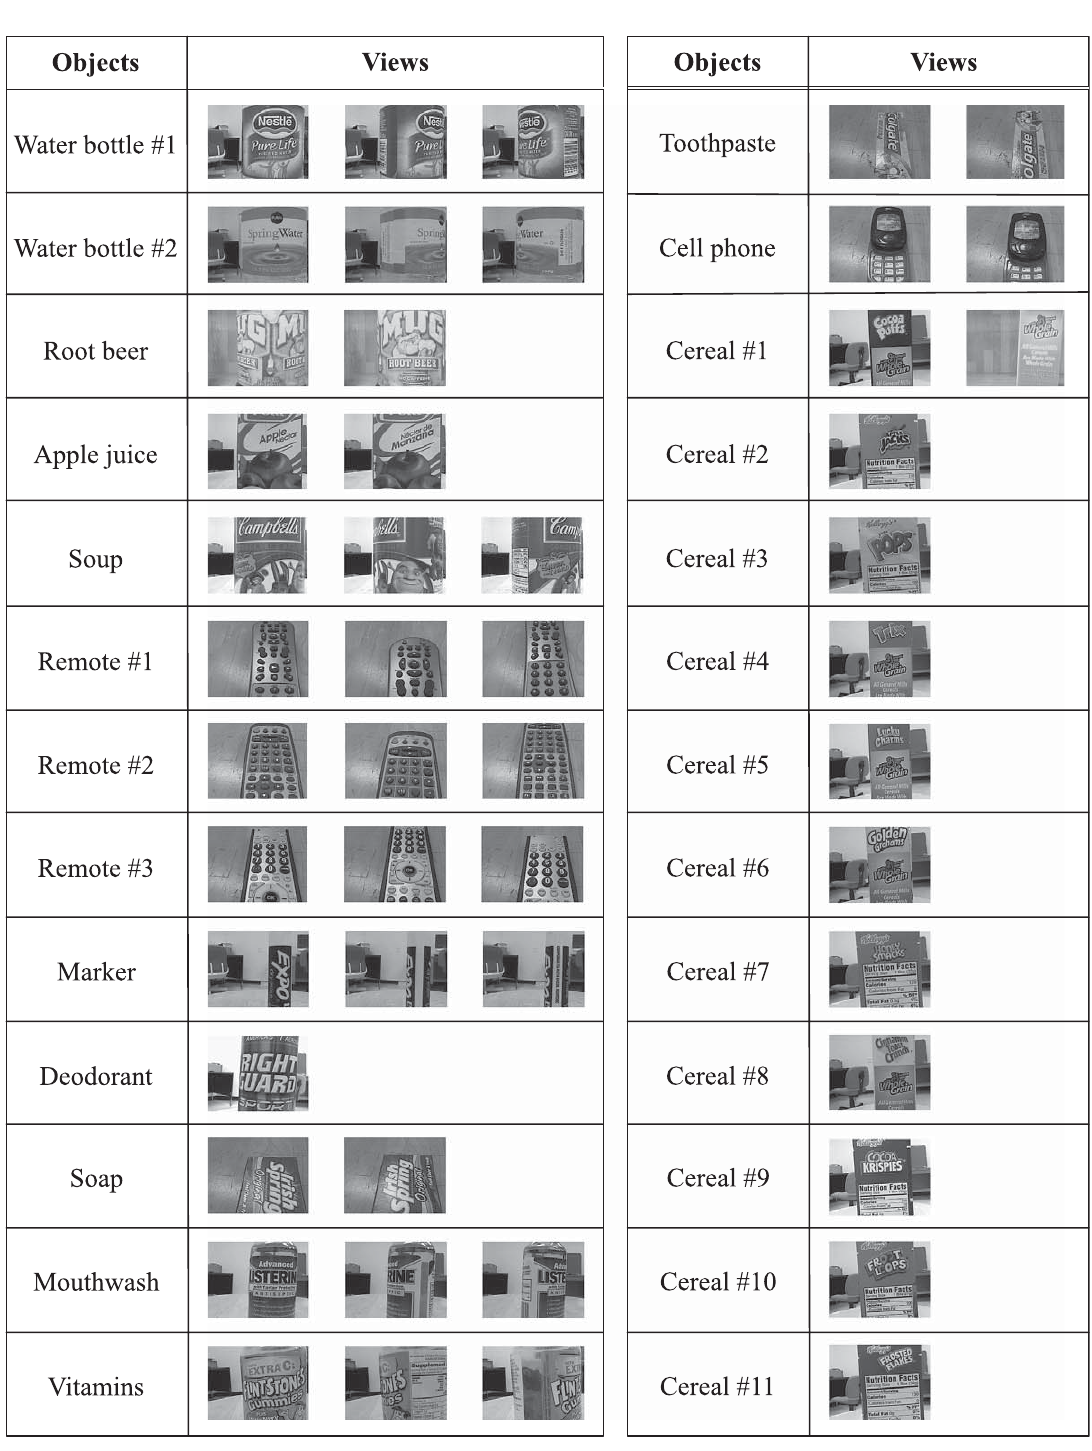
Fig. 6. Template database of 26 unique objects with several having multiple views. Objects are identified using a decision tree that compares